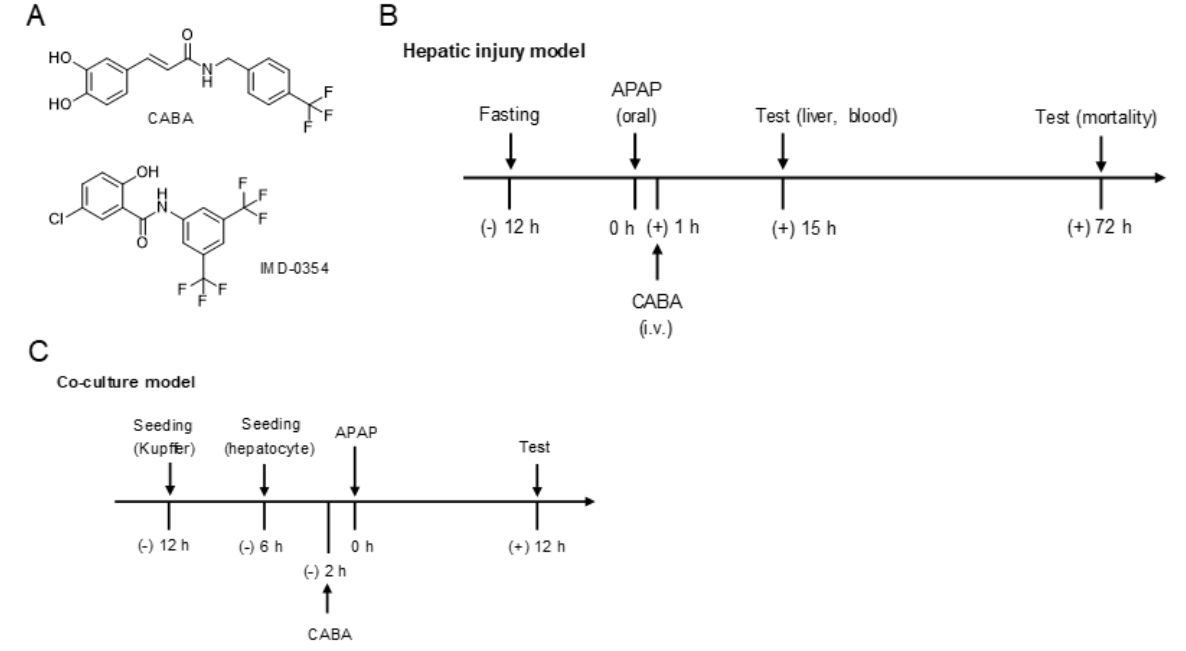
Figure 1. ( A ) Chemical structures of CABA and IMD-0354. ( B ) Experimental protocol of APAP-induced hepatotoxicity in mice. C57BL/6 mice were intravenously treated with CABA at 1 h after oral administration with APAP. ( C ) Experimental protocol in co-culture model. Co-culture between primary hepatocytes and Kupffer cells was pretreated with CABA for 2 h and stimulated with APAP for 12 h in the presence of CABA.